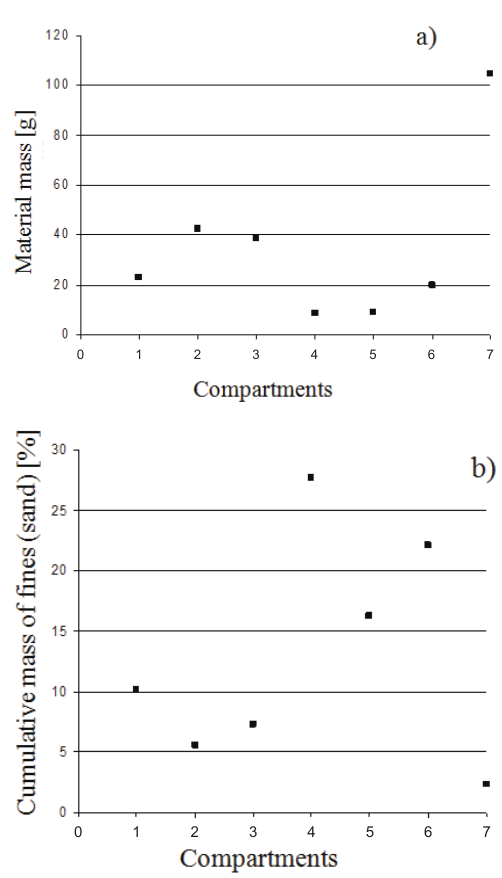
Fig. 7 a) Sand particle mass accumulated in compart- ments 1 to 6 (outside ring) and 7 (central pot), and b) Mass fraction of fine sand (particles smaller than 480 microns) (feeding rate 0.2 kg/ min and water extraction rate 4 L/min).